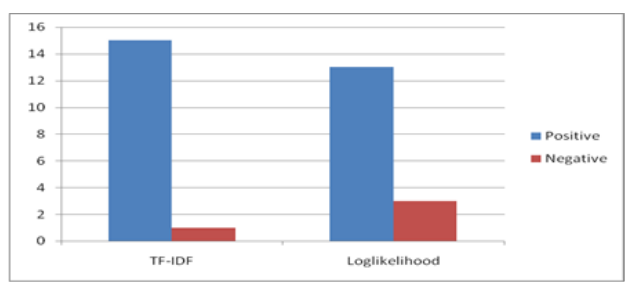
Fig. 4. Keywords as positive or negative of each